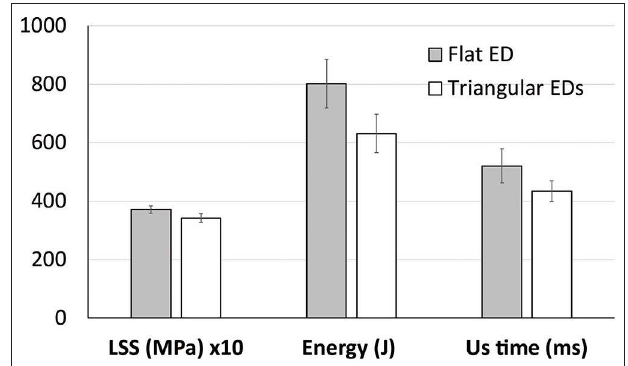
FIGURE 2 | Optical cross-section micrograph showing melting of the tip of the energy directors and resin squeeze out to the sides at the beginning of the welding process. Reprinted from Villegas and Palardy (2017) with permission from Taylor and Francis.